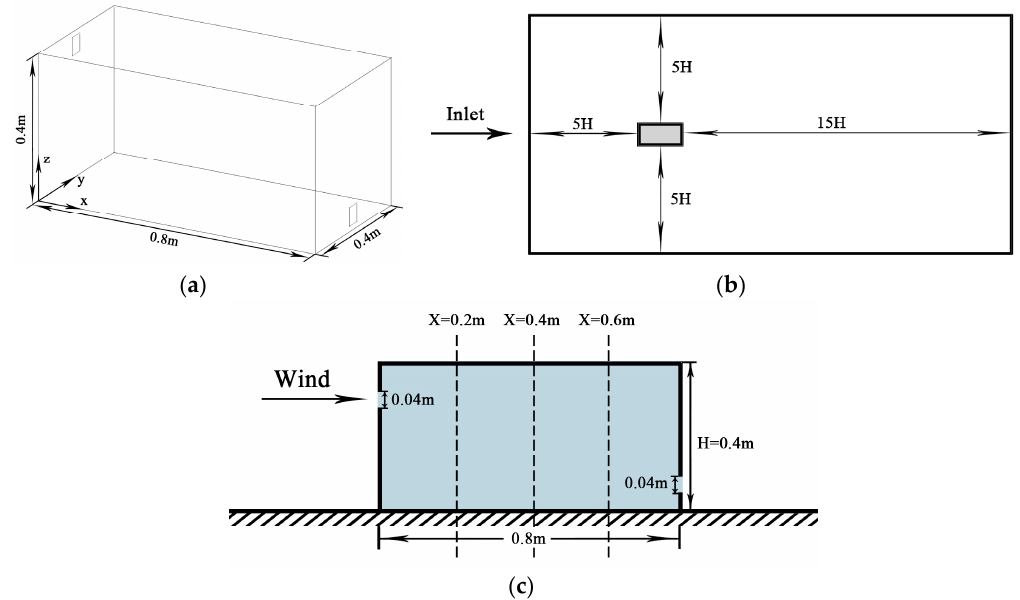
Figure 4. Setup for CFD validation. ( a ) The dimension of the building model replicated in the chamber; ( b ) Top view of the computational domain setting; ( c ) Cross-section along the middle plane ( y = 0.2 m).